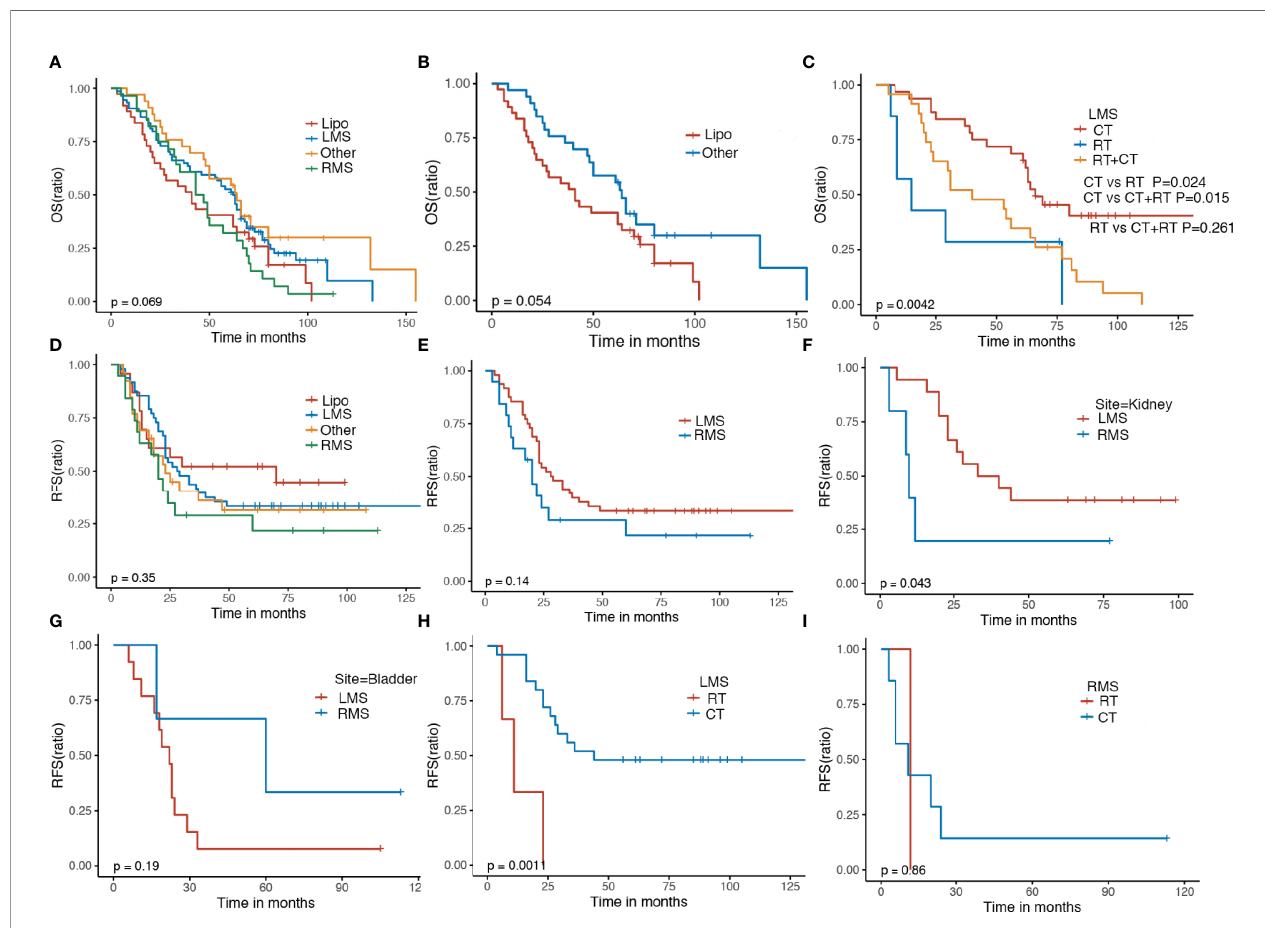
FIGURE 2 | The Kaplan – Meier analyses of GS patients. The Kaplan – Meier survival estimates of (A, B) OS and (D, E) RFS strati fi ed by histological types. The Kaplan – Meier survival estimates of (C) OS of LMS strati fi ed by adjuvant treatment. The Kaplan – Meier RFS survival analysis of GS patients of kidney (F) , bladder (G) , LMS (H) , and RMS (I) strati fi ed by adjuvant therapy. OS, overall survival; RFS, recurrence-free survival; LMS, leiomyosarcoma; RMS, rhabdomyosarcoma; Lipo, Liposarcoma; CT, chemotherapy; RT,